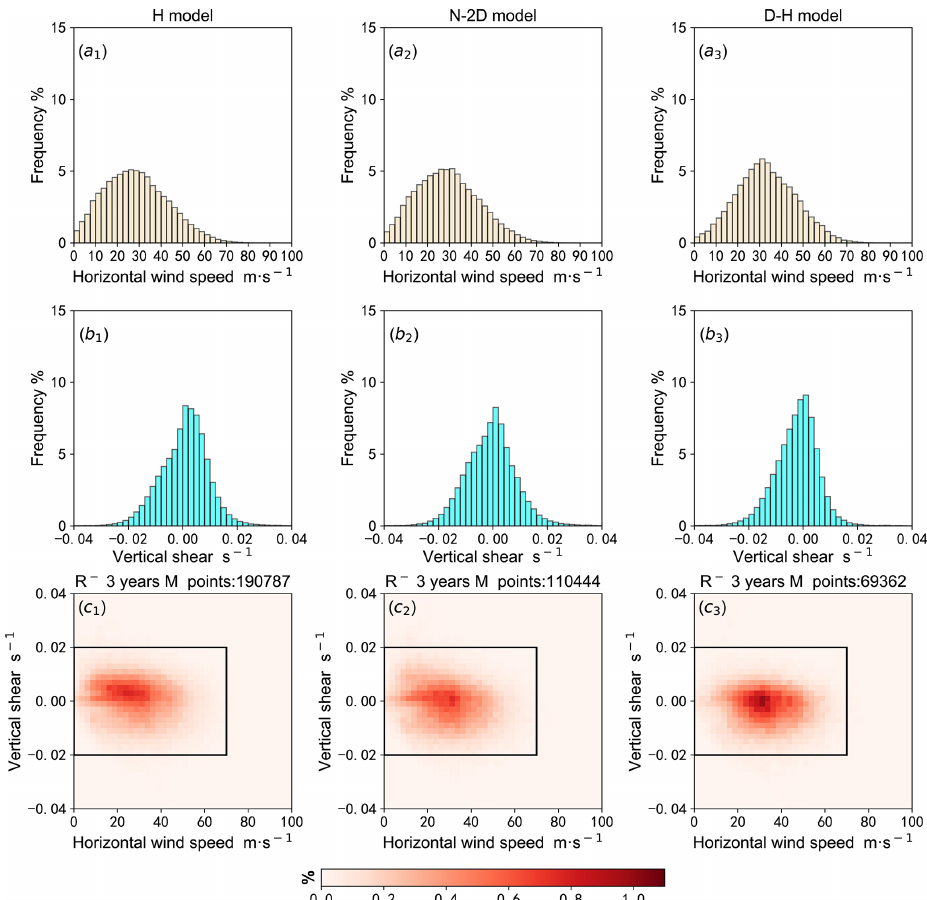
Figure 2. Frequency distribution of (a.1–a.3) horizontal wind speed and (b.1–b.3) the vertical shear of horizontal wind speed, along with (c.1–c.3) the two-dimensional frequency distribution characteristics of horizontal wind speed and the vertical shear of horizontal wind speed for the H model (a.1, b.1, c.1) , N-2D model (a.2, b.2, c.2) and D–H model (a.3, b.3, c.3) when the turbulent kinetic energy is